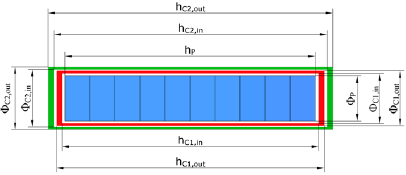
Figure 1. Technical drawing of the MINERVE samples, con- sisting of a ten-pellet stack (in blue) contained in two Zircaloy-4 containers (in red and